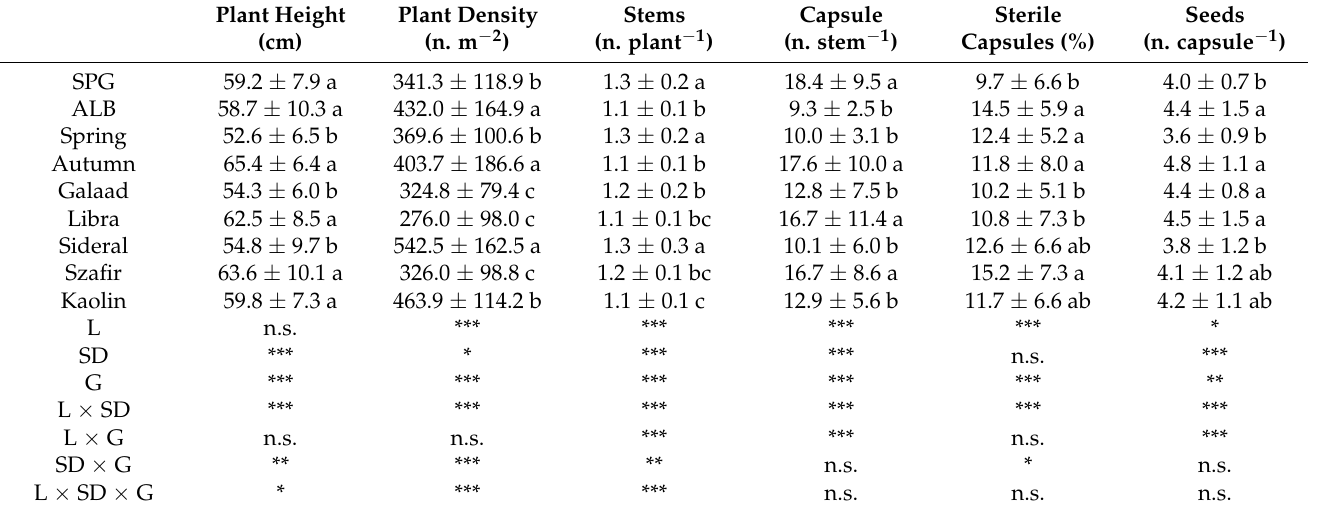
Table 3. Main effects of location (L), sowing date (SD) and genotype (G) and their interaction on linseed plant height, plant density, number of stems per plant, number of capsules per stem, sterile capsule percentage, and number of seeds per capsule. Data refer to mean values ± standard